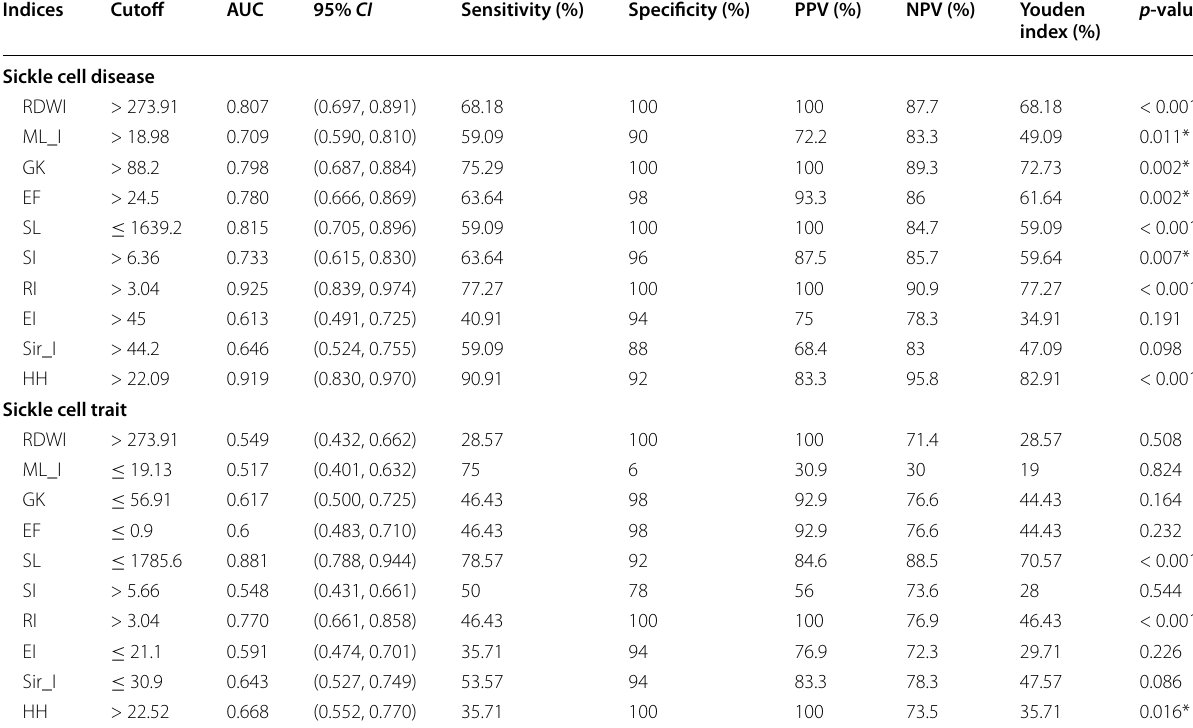
Table 5 The curve of receiver operating characteristic (ROC) of the studied indices for optimum cutoff points in diagnosing sickle cell disease and trait (compared to healthy control)